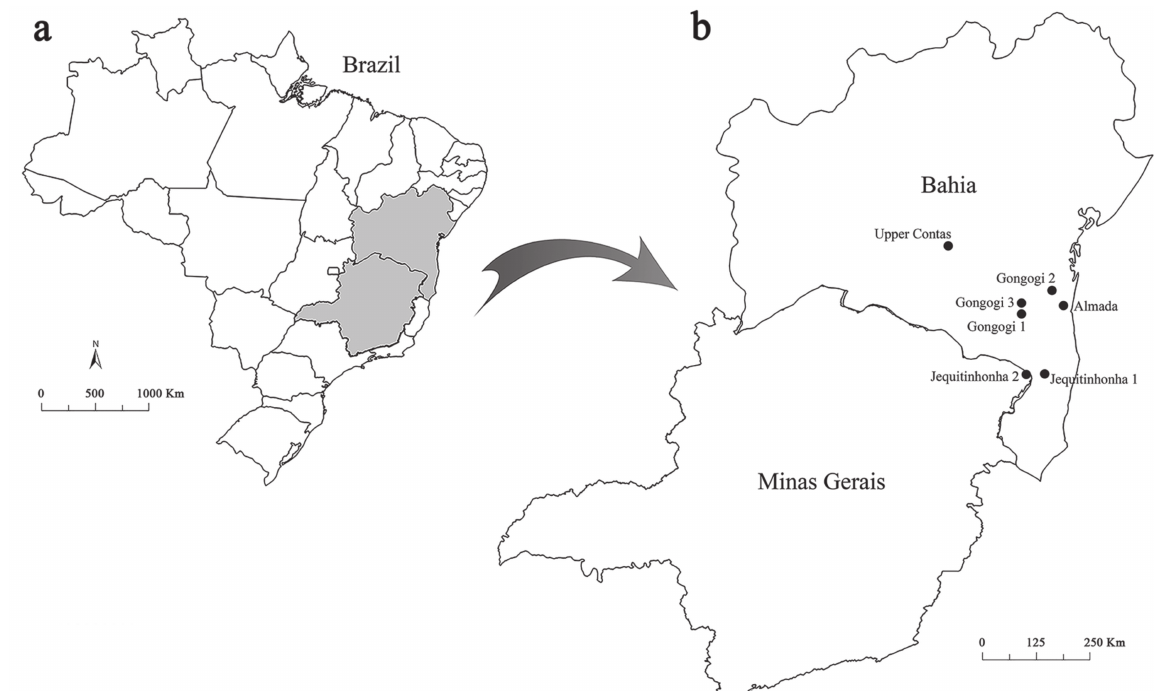
Fig. 1. Map of Brazil (a) and collection sites (b) of Nematocharax venustus along the Almada (Almada), Contas (Upper Contas, Gongogi 1, 2, and 3), and Jequitinhonha River basins (Jequitinhonha 1 and 2) in the states of Bahia and Minas